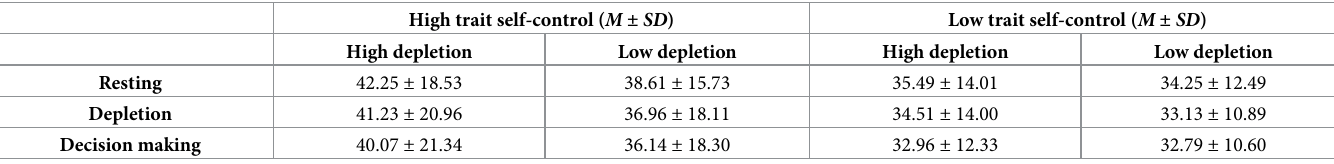
Table 8. Descriptive statistics of HRV in the stages of resting, depletion and decision